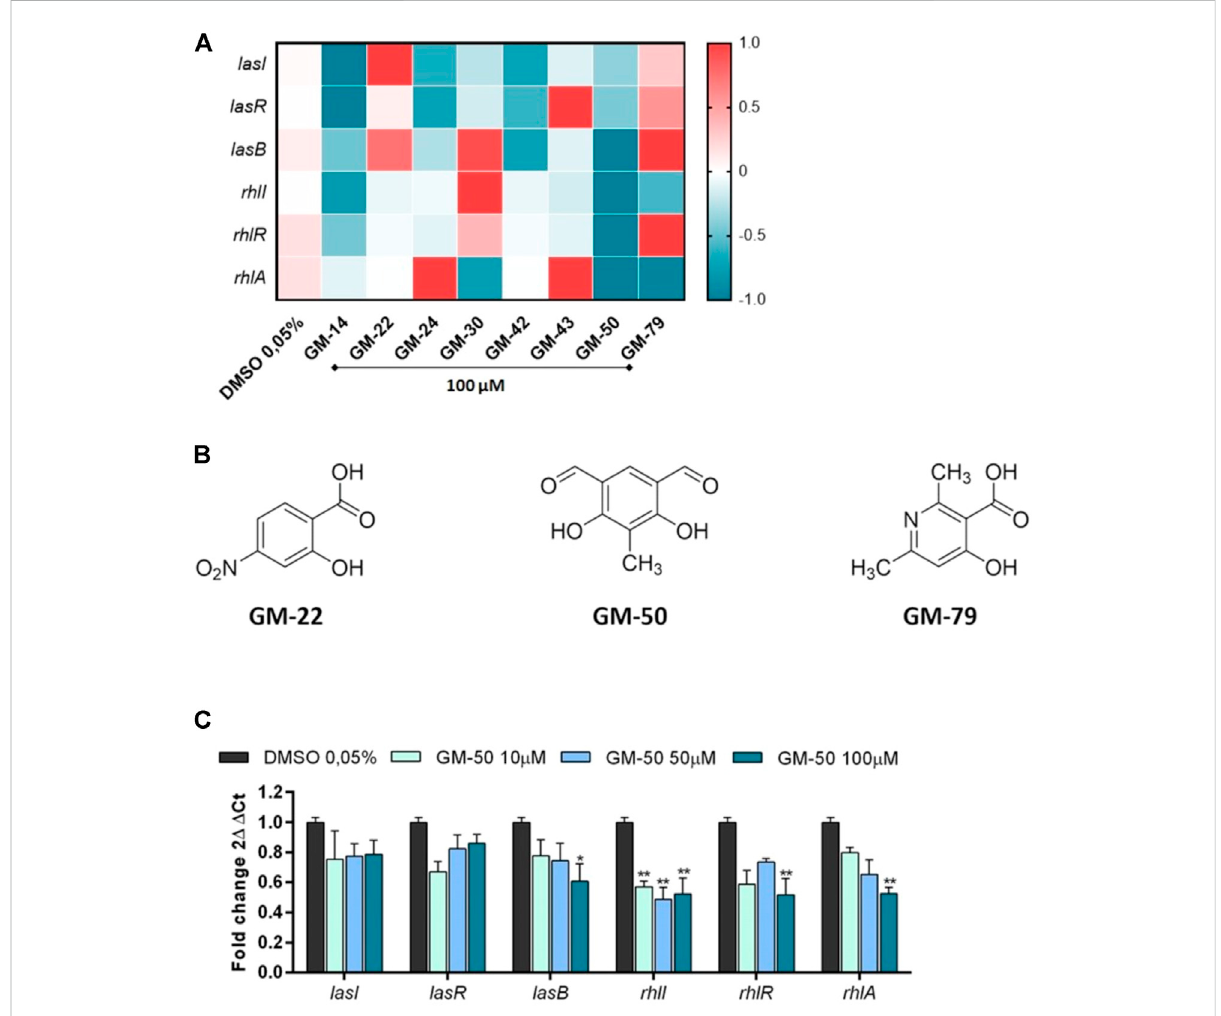
FIGURE 1 Effect of compounds selected by bioluminescence assay on the expression of AHL-sensitive genes. (A) Heatmap illustrating differential gene expression over vehicle-treated controls. PAO1 (10 6 CFU/ml) cultures were treated with 100 µM of compounds GM-14, GM-22, GM-24, GM-30, GM-42,GM-43,GM-50,GM-79orwithvehicle(DMSO0.05%)for24 hat37 ° C.TranscriptlevelsofAHL-responsivegenes lasR/lasI/lasB and rhlR/rhlI/ rhlA, were assessed by qRT-PCR. Expression values for each gene (rows) are normalized across all samples (columns) by proC expression. Positivecorrelationsaremarkedinredandnegativeonesinblue(colorscaleattop). (B) ChemicalstructuresofGM-22,GM-50,andGM-79. (C) PAO1 (10 6 CFU/ml) were cultured in LB with GM-50 (10, 50, and 100 μ M). After 24 h, LasR/lasI/lasB and rhlR/rhlI/rhlA mRNA transcript levels were determined by qRT-PCR. Results are reported as 2 ΔΔ Ct of relative gene expression ( n = 3). * p < 0.05, ** p < 0.01 vs. PAO1 with DMSO